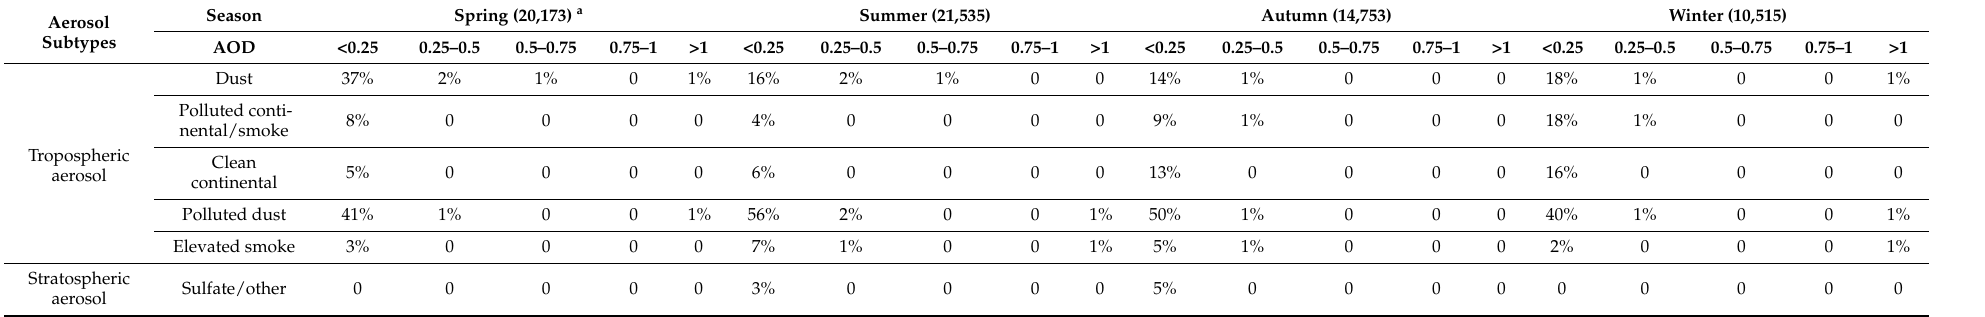
Table 1. Percent frequency of different aerosol types at aerosol optical depth (AOD) in the ASB for years 2007 to